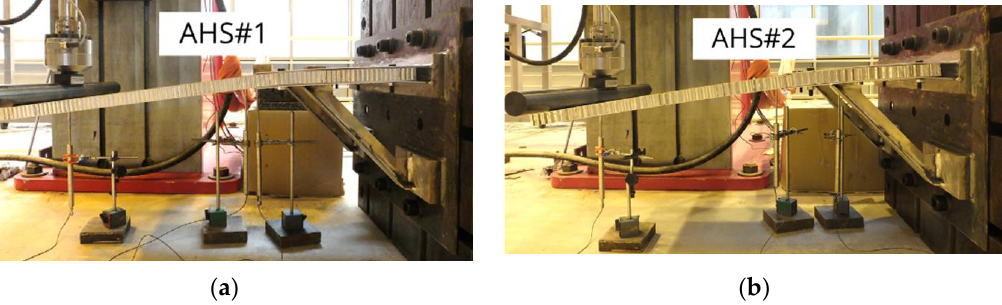
Figure 7. Balcony panels at the final displacement applied during the first run of quasi-static tests; ( a ) AHS#1, ( b ) AHS#2.